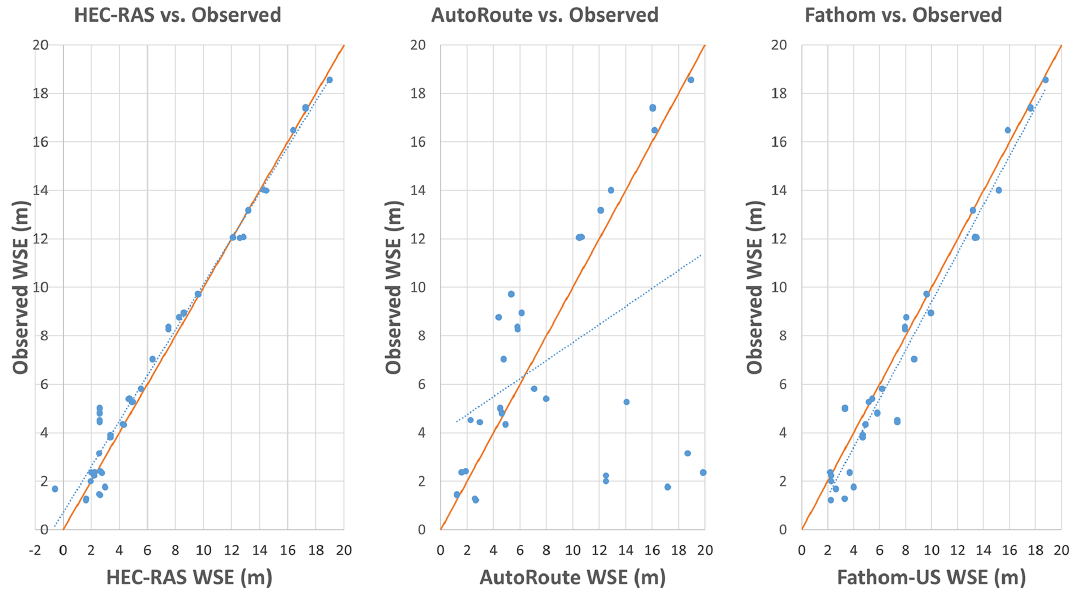
Figure 4. Scatterplot comparing simulated and observed WSEs for Hurricane Harvey. Here, each blue dot represents an observed HWM location, the orange line represents a 1 : 1 perfect fit, and the dotted blue line is the line of best fit between the observed and simulated WSE at the HWM locations.